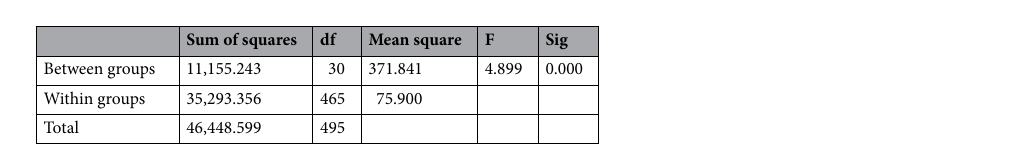
Table 13. One-way ANOVA for Nargis MSW.